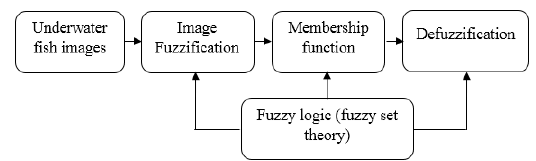
Figure 1: Work flow of modified fuzzy set